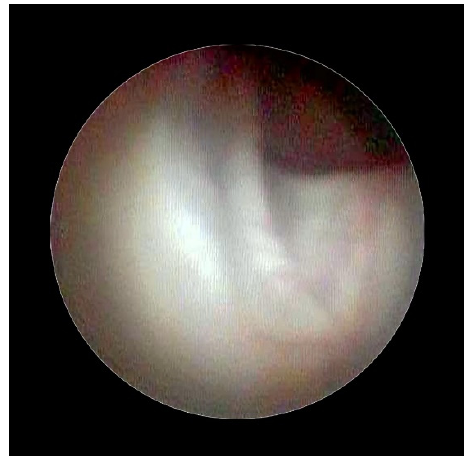
Figure 1. Normal dura in epiduroscopy.